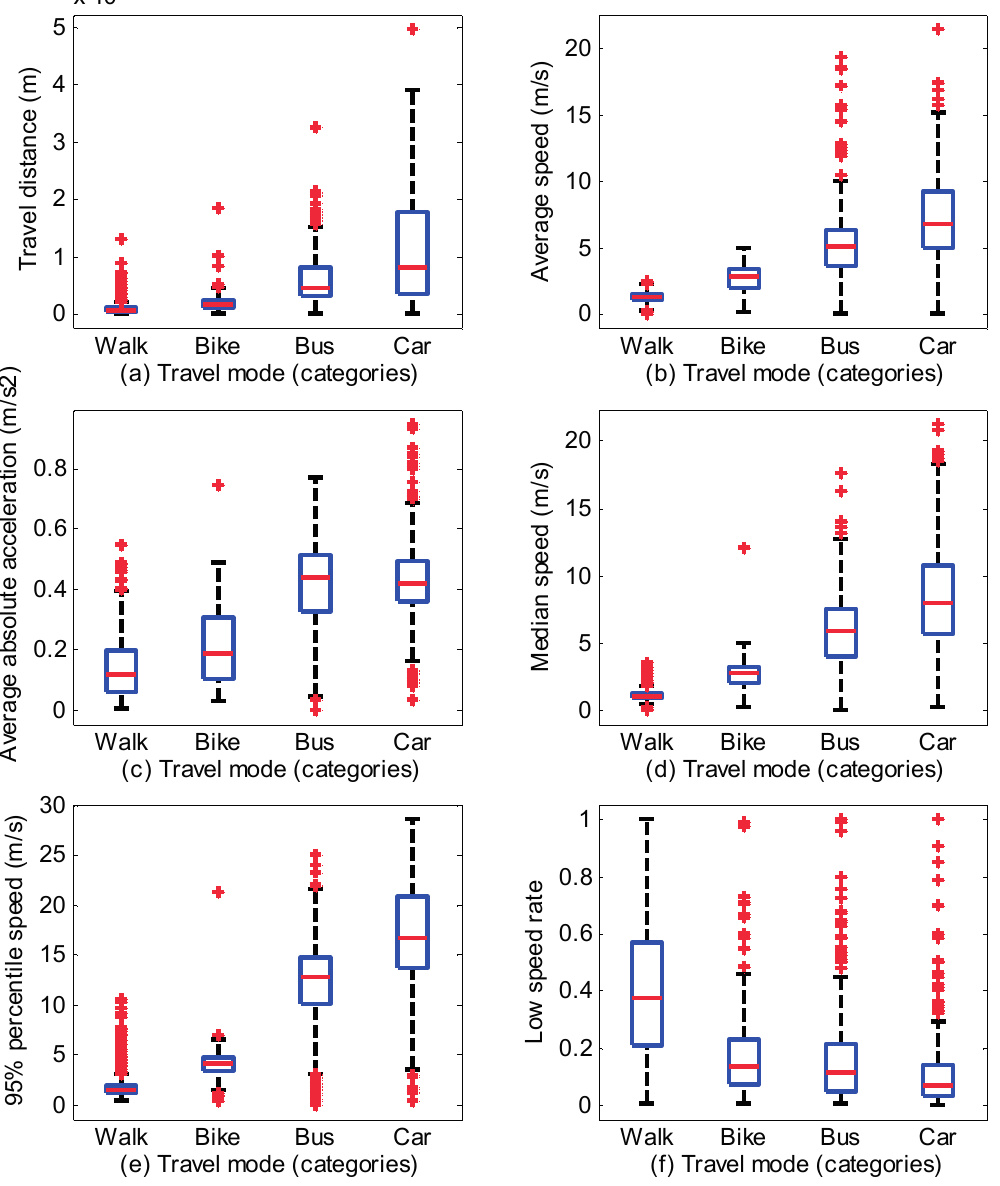
Figure 1. Distribution of six